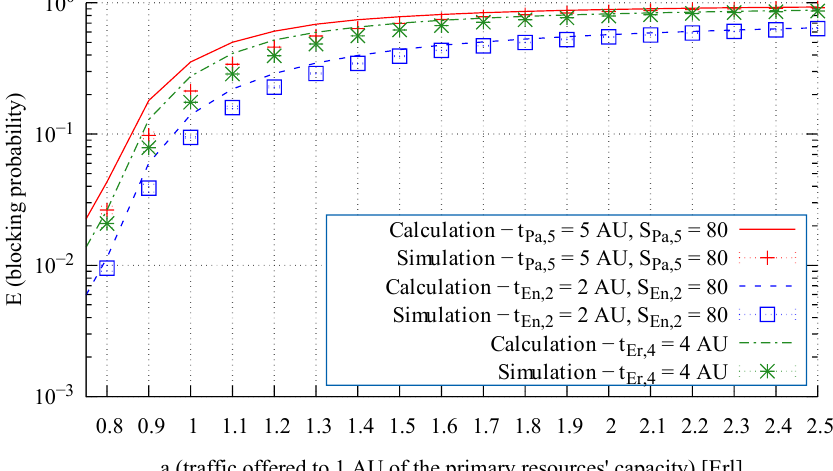
Figure 9. Blocking probability of particular traffic classes in the alternative resources of System 3.